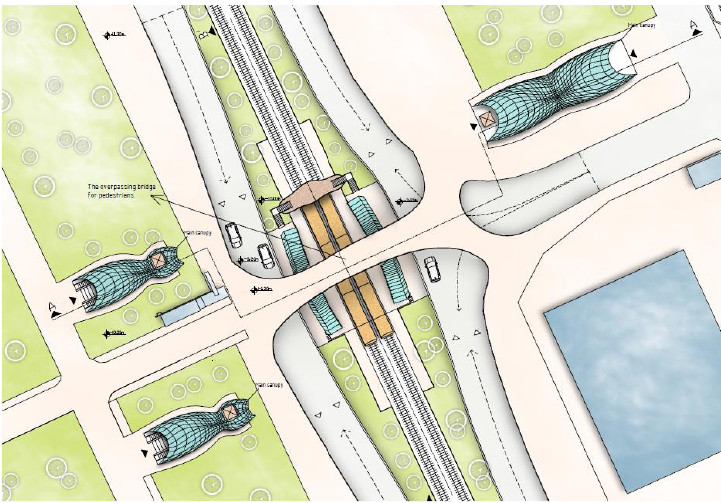
Figure 9 An alternative design solution where the designer suggested a multilayer solution; pedestrian on the ground, vehicle in the middle, and the railway system at the bottom. Yet, with a landscape design, it is also possible to provide daylight to every level of the station (Oruç Türk)